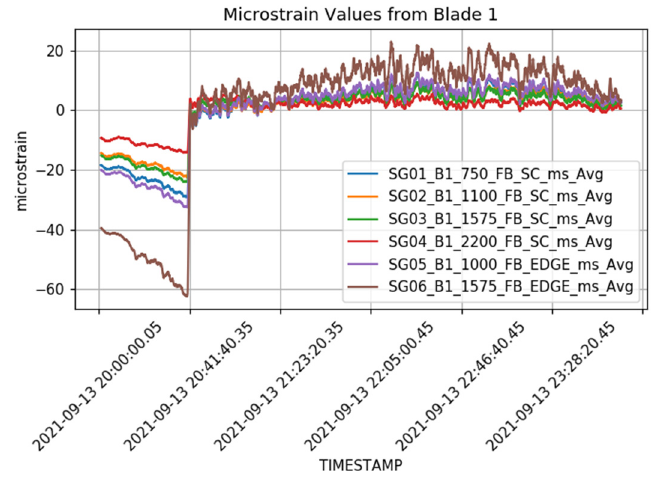
Figure 11. Strain gage data for thermoplastic Blade 1 during deployment, showing 4 h of data collected in September when the rotor was parked due to the junction box failure. The step change shows the rotor going from parked to operating.